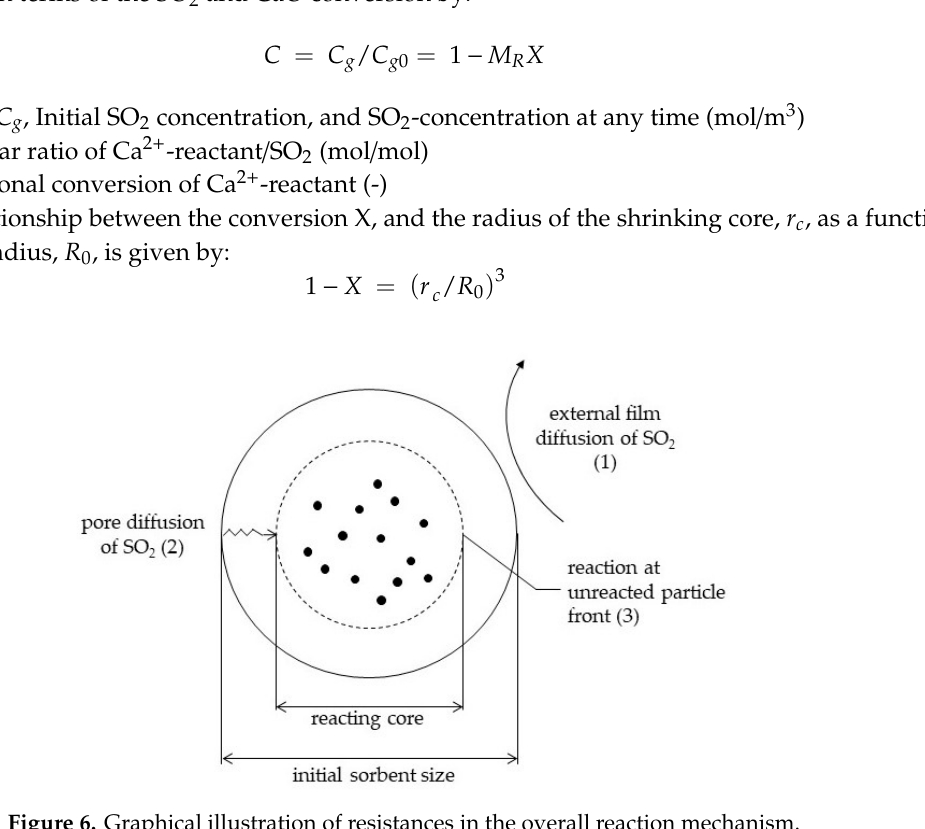
Figure 6. Graphical illustration of resistances in the overall reaction mechanism.